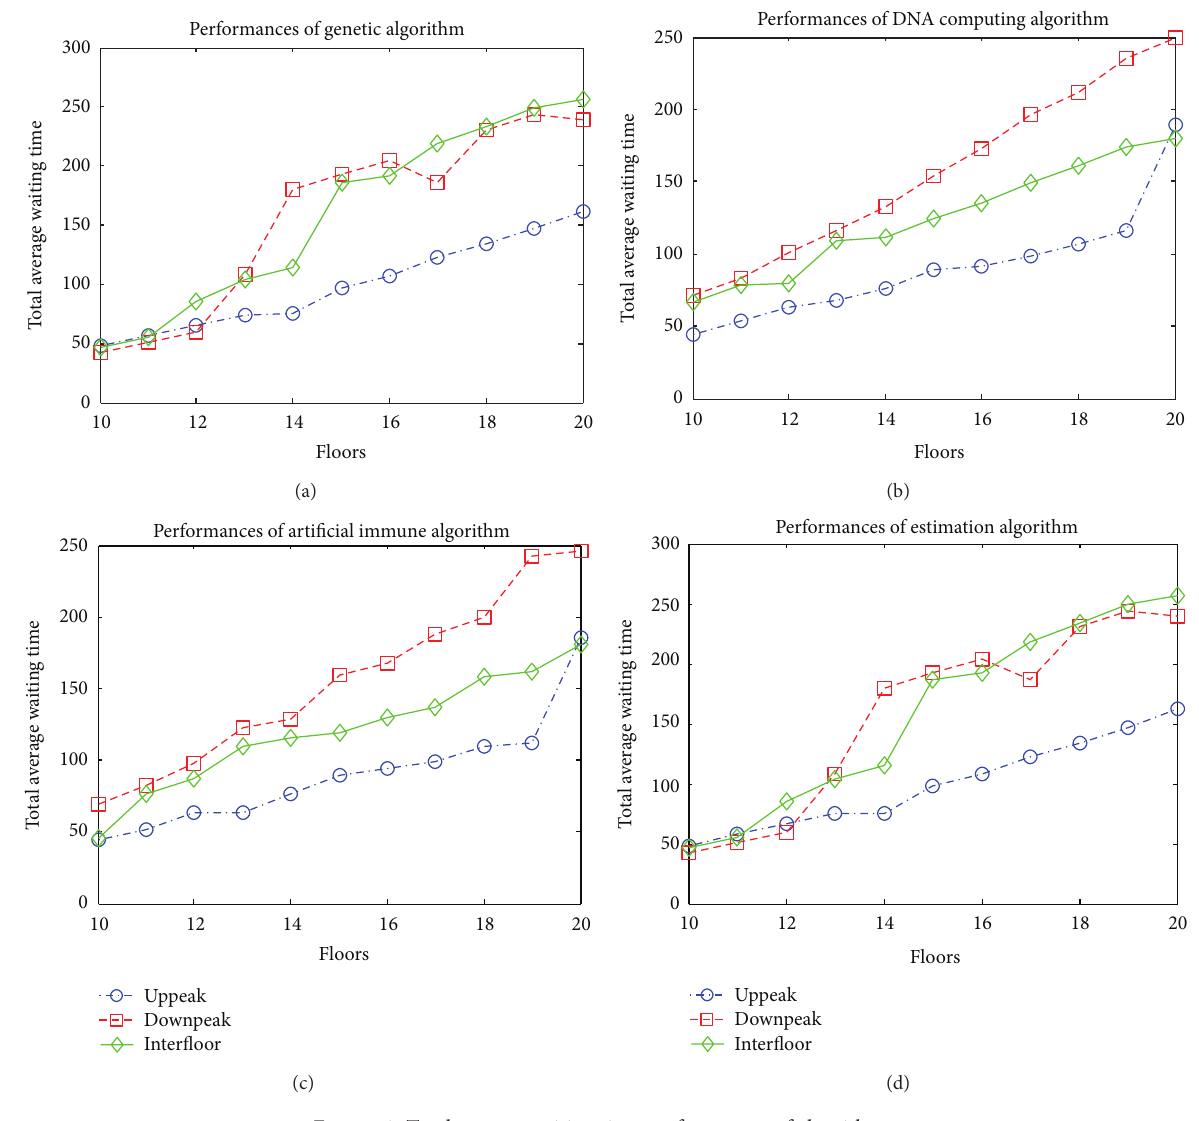
Figure 9: Total average waiting time performances of